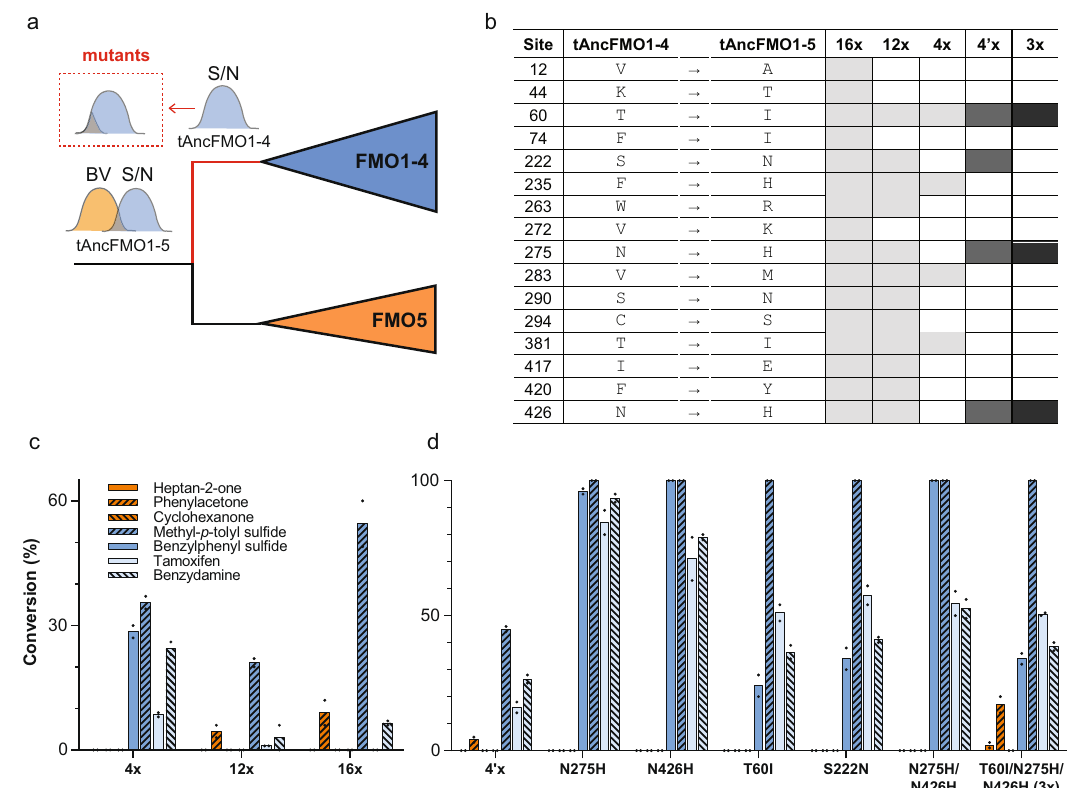
Fig. 3 | Disclosing thesequence determinantsofthe BV activity by mutational analysis. a Scheme depicting the reverse mutational strategy in terms of func- tionalities as landscapes in the sequence space 23 . b List of sites mutated in each of the constructed variants. The subsequent rounds of mutations are represented in